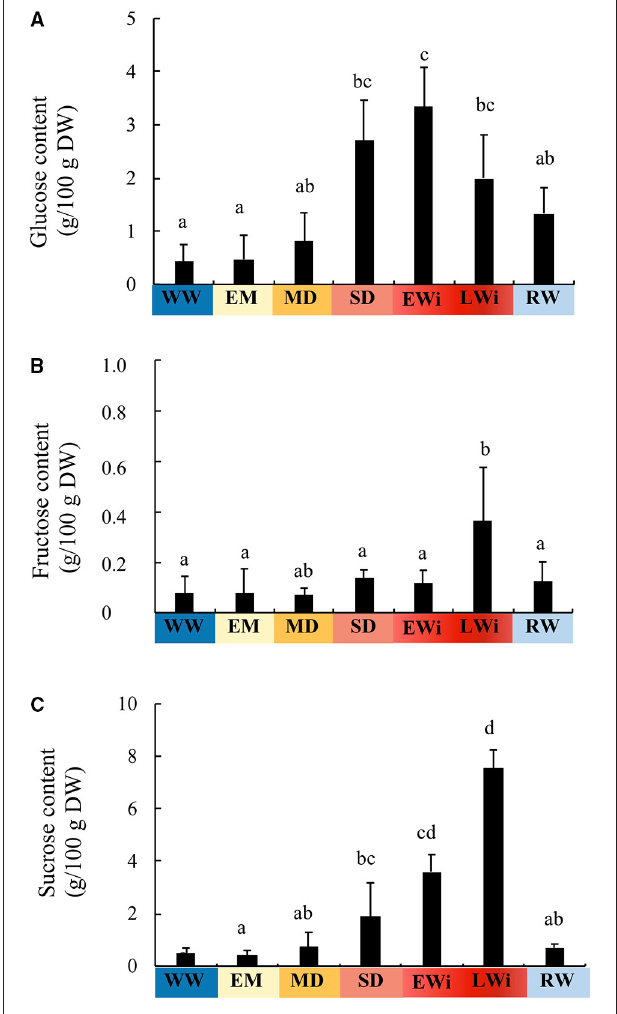
FIGURE 4 | Sugar content in the leaves of A. thaliana Col-0. (A) glucose content, (B) fructose content, and (C) sucrose content as function of the four phases of water deficit: EM, early mild water deficit; MD, moderate water deficit; SD, severe water deficit; EWi, early wilting; LWi, late wilting. The study was carried out with five plants per condition and three independent biological repeats were performed ( ± SD). The Kruskal–Wallis test, followed by Dunn’s multiple comparisons test ( p < 0.05) with the Bonferroni correction, resulted in significantly different groups, as indicated by different